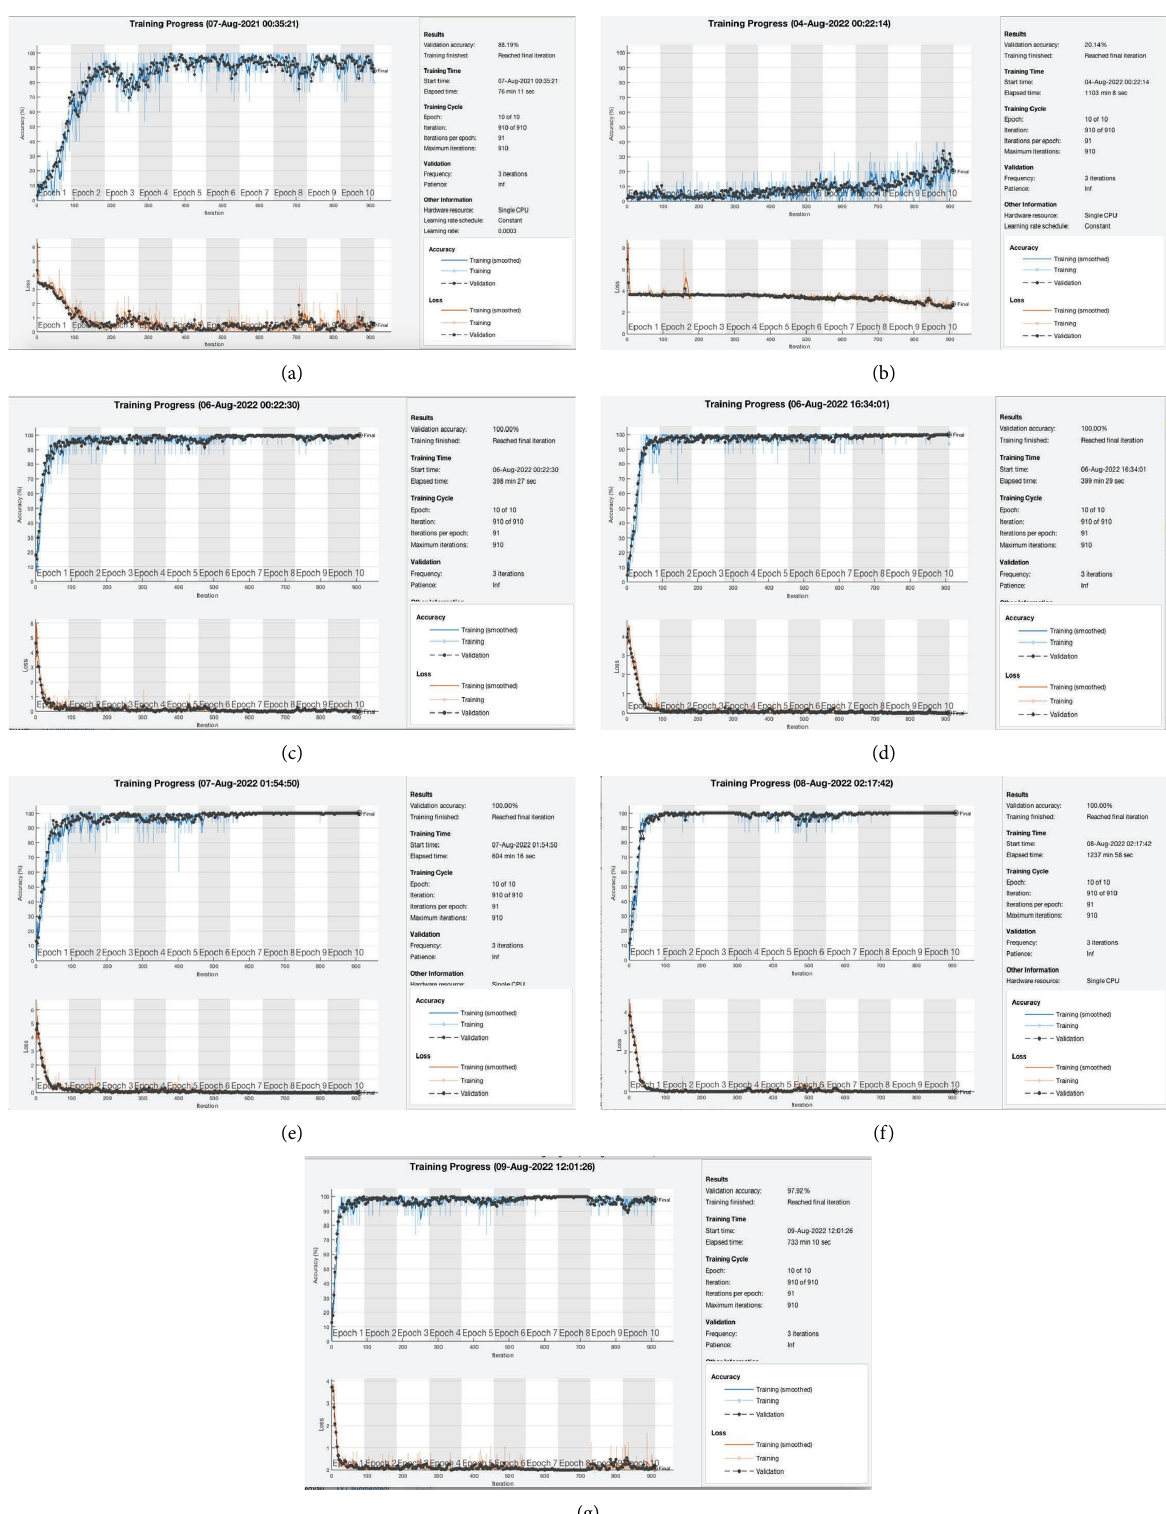
Figure 11: Learning curves of the main dataset for the seven pretrained models. (a) AlexNet, (b) VGG16, (c) ResNet50, (d) NasNetMobile, (e) InceptionV3, (f) Xception, and (g)